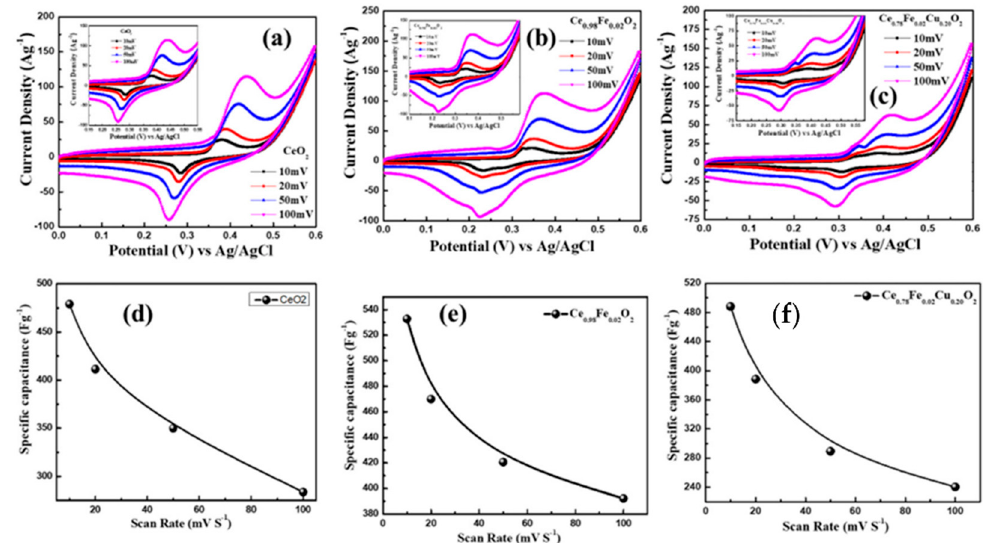
Figure 6. ( a – c ) CV plots of CeO 2 , Ce 0.98 Fe 0.02 O 2 , and Ce 0.78 Fe 0.02 Cu 0.20 O 2 nanoparticles with different scan rates. ( d – f ) Variation in specific capacitance of CeO 2 , Ce 0.98 Fe 0.02 O 2 , and Ce 0.78 Fe 0.02 Cu 0.20 O 2 nanoparticle electrodes with different scan rates.